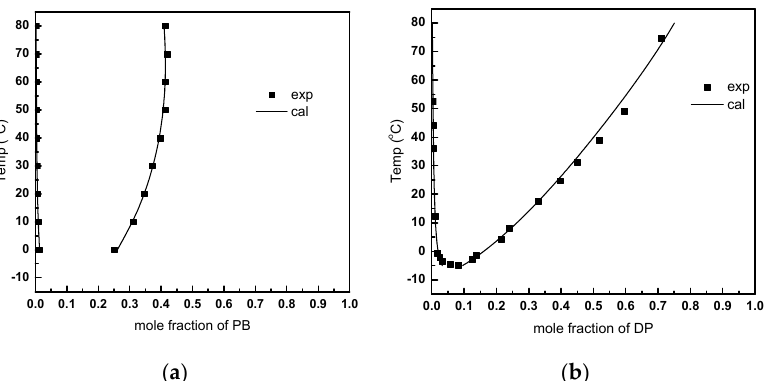
Figure 9. Liquid-liquid equilibrium diagram of a lower critical solution temperature (LCST) organic solvents + water system; ( a ) propylene glycol n-butyl ether (PB) + water; ( b ) dipropylamine (DP) + water.